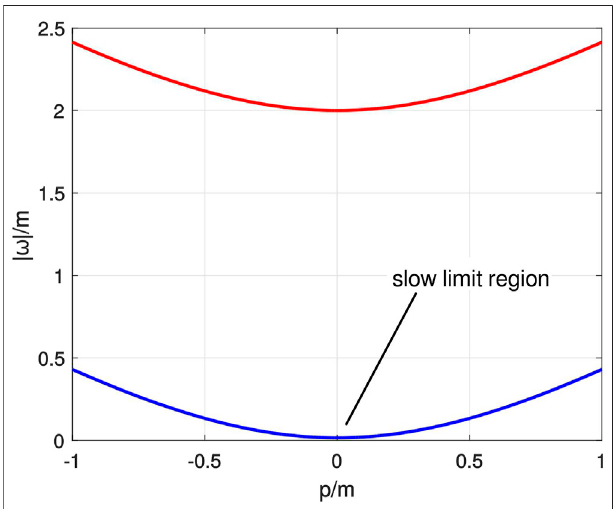
FIGURE 1 | Absolute value of the dispersion relations of the complex Klein-Gordon fi eld ψ , as given in Eq. 37 . The blue curve refers to the gapless mode ω + , the red line is the gapped mode ω −